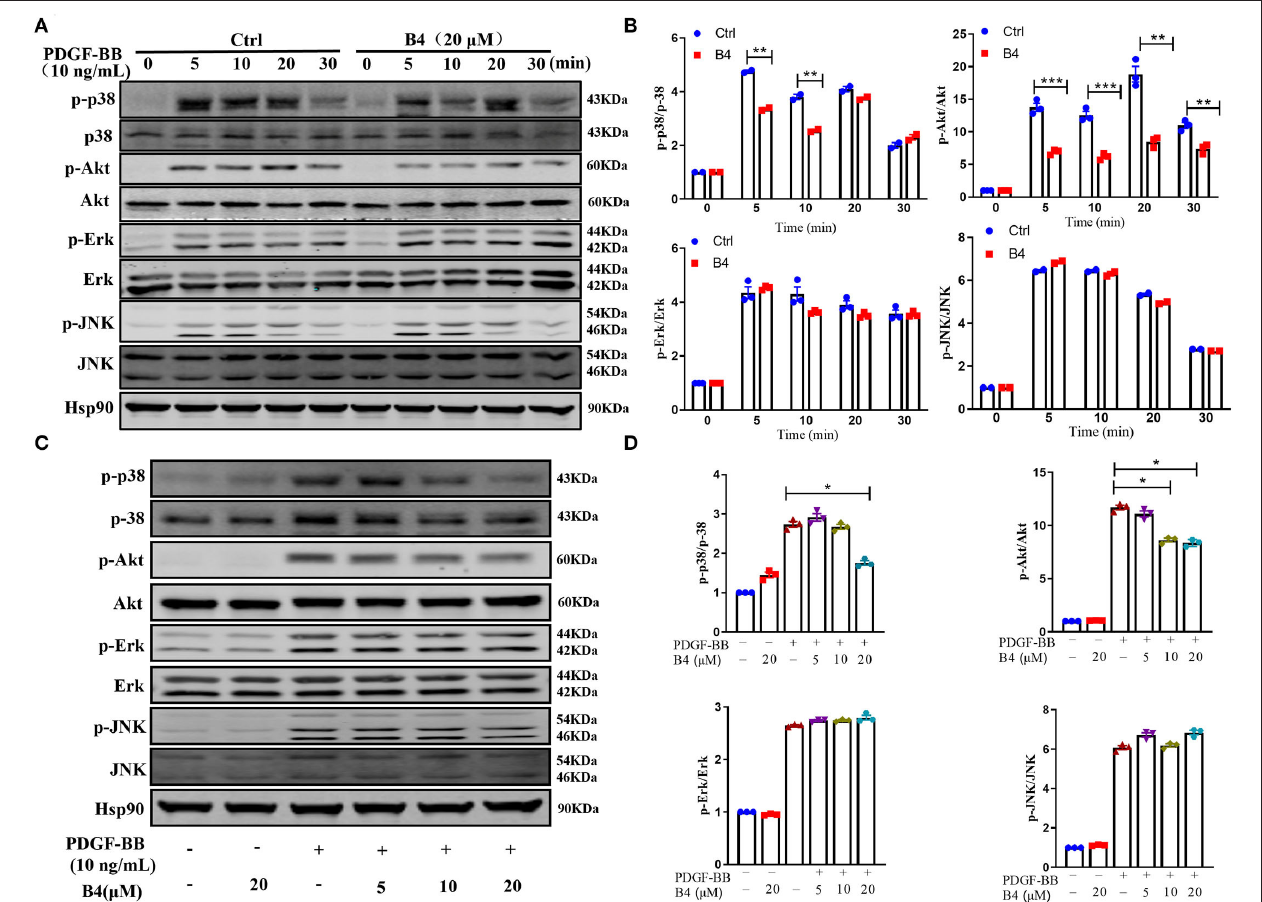
FIGURE 5 | B4 inhibits PDGF-BB-induced PI3K/Akt and p-38 MAPK signaling pathway. (A) Western blot analysis of p-Akt/Akt, p-p38/p38, p-ERK/ERK, p-JNK/JNK in MVSMCs treated with B4 for 24h and stimulated with PDGF-BB for 0–30min. Hsp90 was used as the loading control. (B) Densitometry analysis of the phosphorylation protein normalized to the total protein levels. (C) Western blot analysis of MVSMCs treated with different concentrations of B4 (0, 5, 10, 20 µ M) for 24h and stimulated with PDGF-BB 10ng/ml for 15min. The protein expression levels of p-p38/p38, p-Akt/Akt, p-ERK/ERK, and p-JNK/JNK were blotted. Hsp90 was used as a loading control. Representative western blots from three experiments are shown. (D) Densitometrical analysis of the western blots. Data shown are means ± SEM. N = 3. * P < 0.05; ** P < 0.01; *** P < 0.001; compared to non-stimulated control group. All experiments were repeated at least for three